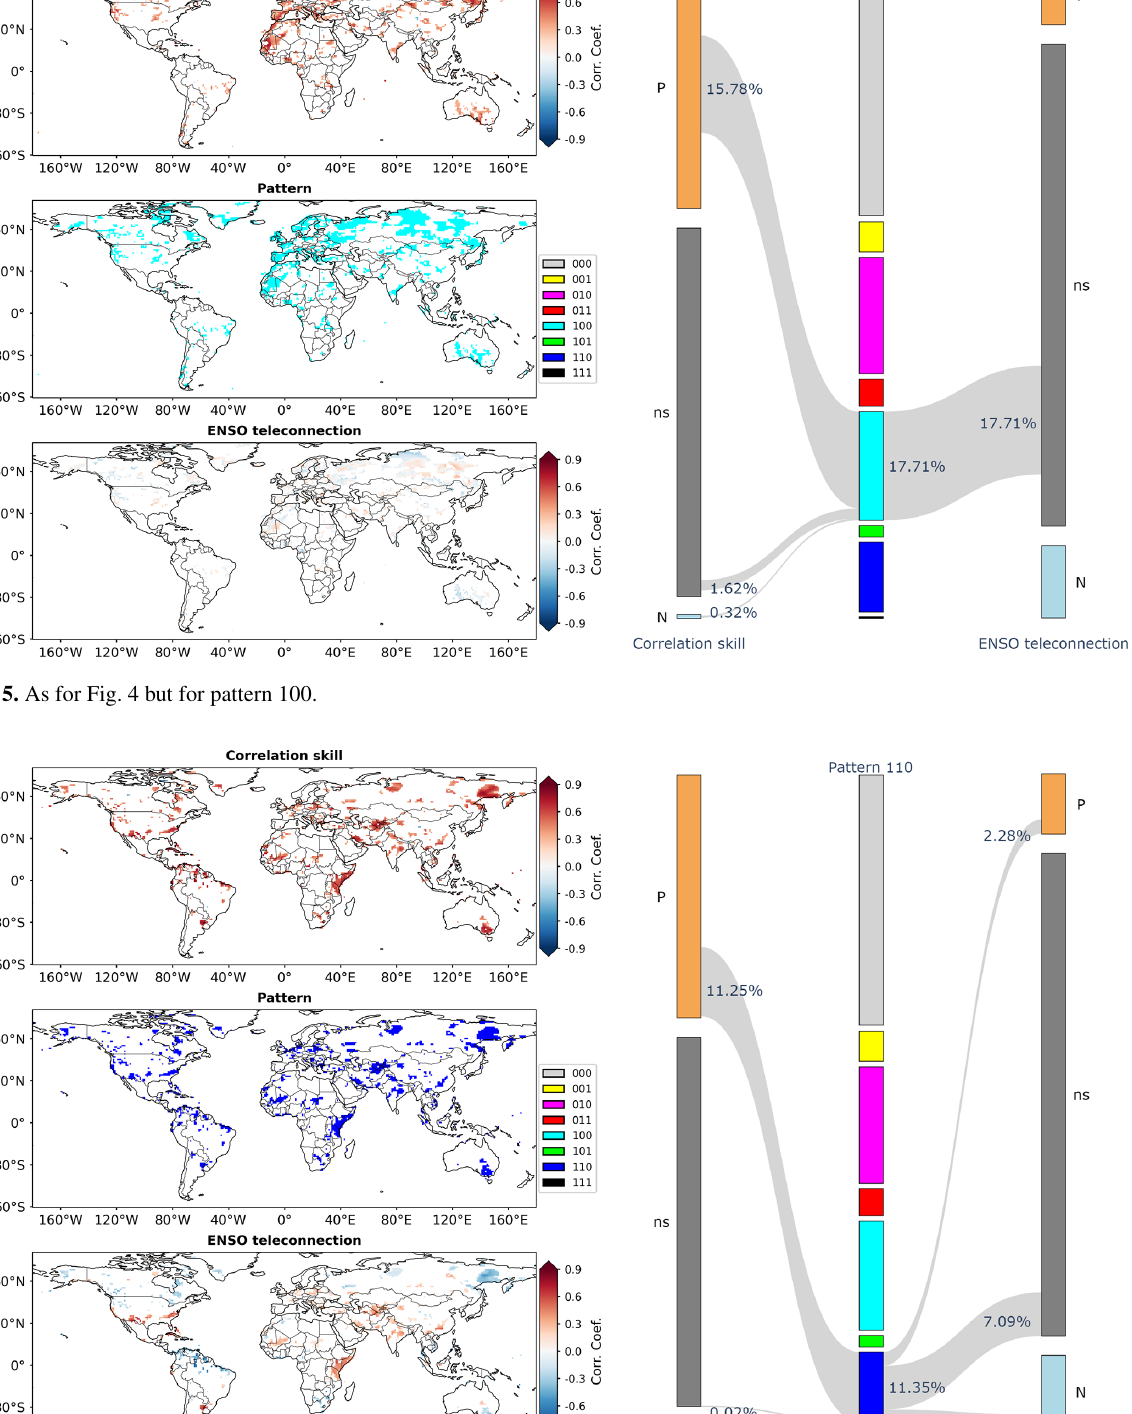
Hydrol. Earth Syst. Sci., 26, 4233–4249, 2022